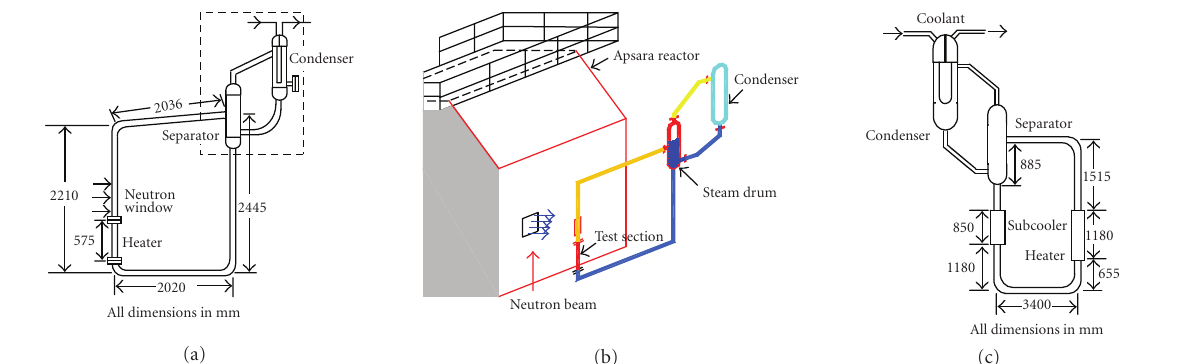
Figure 6: Schematic of the di ff erent test loops.